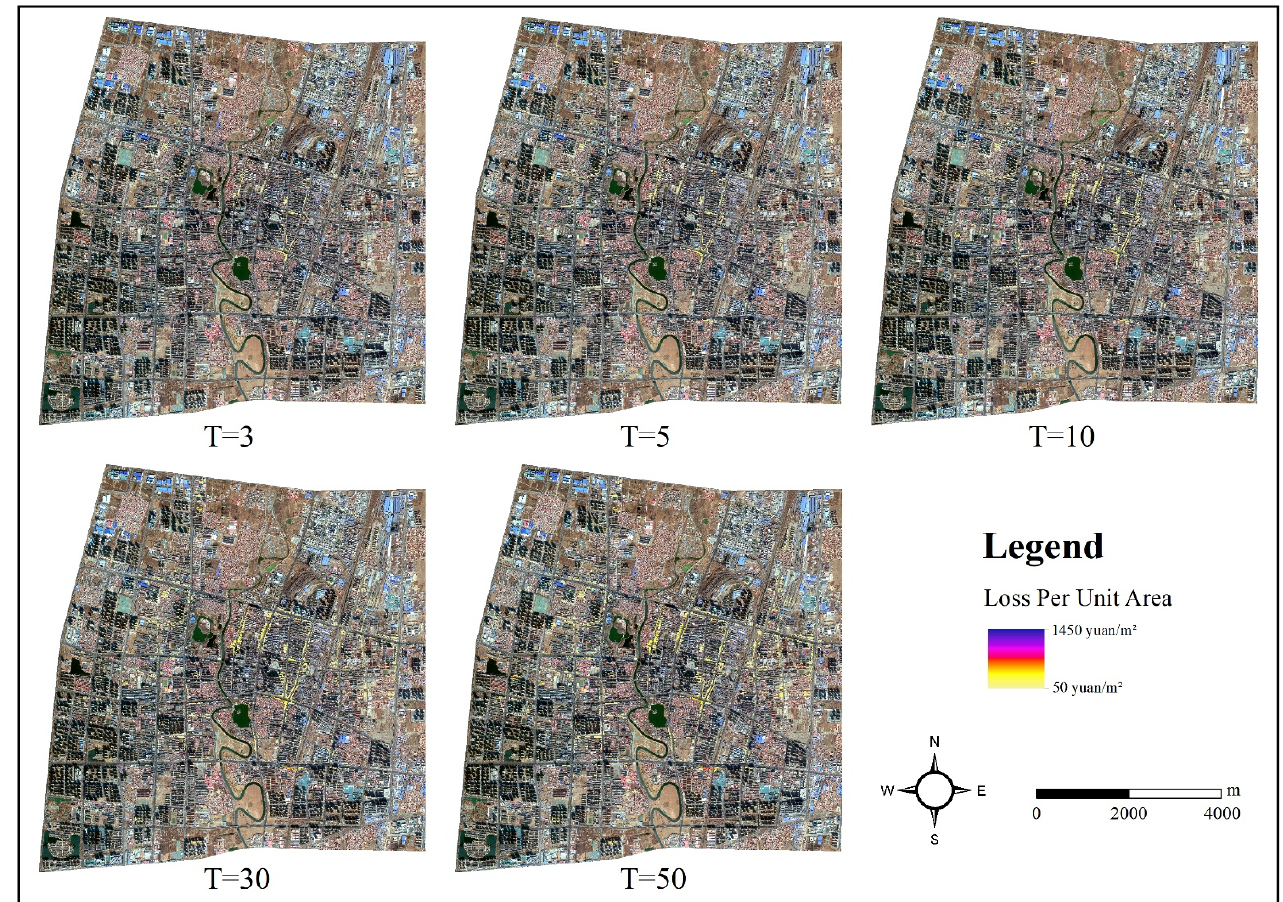
Figure 10. Spatial distribution of the inundation loss per unit area under different return periods.